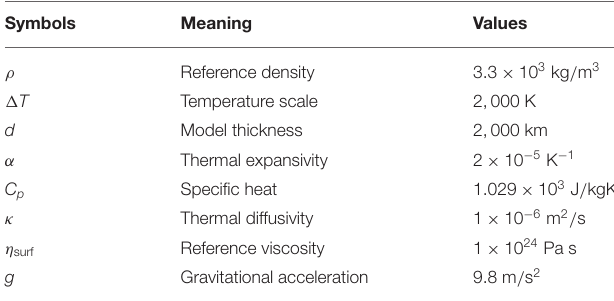
TABLE 1 | Meanings and values of symbols in this